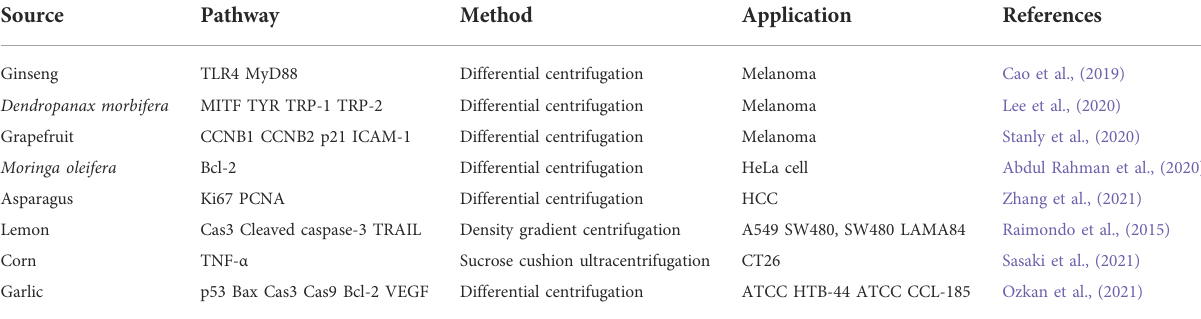
TABLE 1 Sources, pathways, extraction methods and applications of